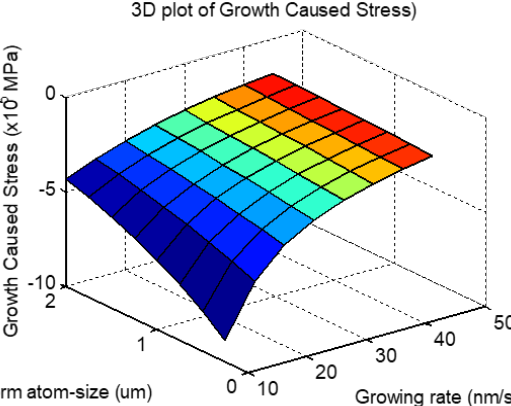
Figure 4. Numerical simulations for the growth-caused stress of SiO 2 film vs. both the growth rate and normalized atom size, where the parameters used in the simulations are set as: T f = 6.0 µ m, L = 6.0 µ m, β D = 0.117 × 10 − 15 m 2 / s, ∆ γ = 0.13 J, δµ s = 0.13 × 10 − 6 V.